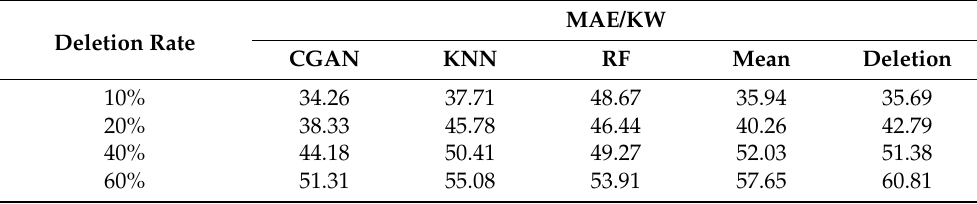
Table 6. Influence of different processing methods on mean absolute error of